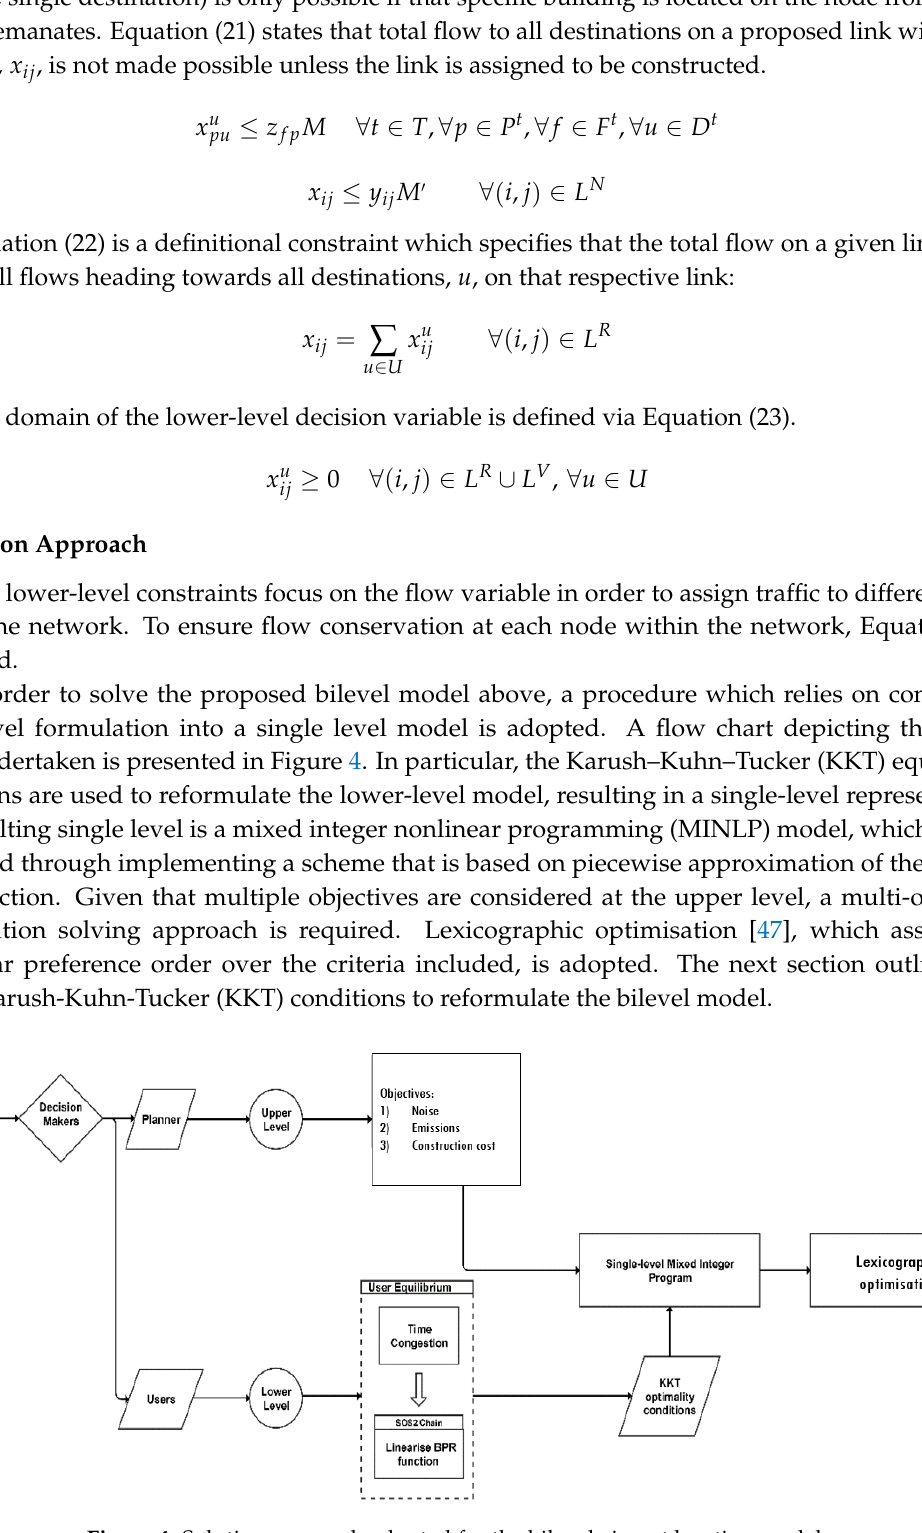
Figure 4. Solution approach adopted for the bilevel airport location model.